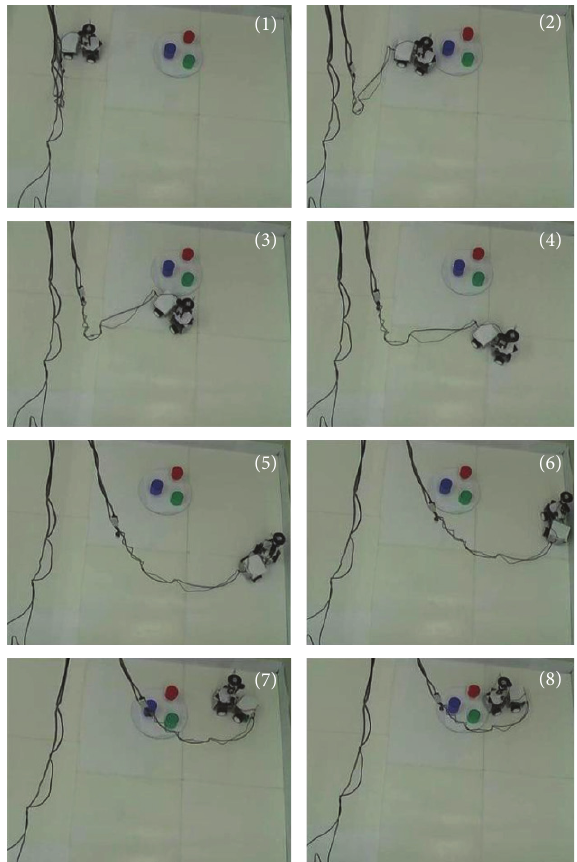
Figure 20: The snapshots of the second experiment where the initial position of the robot is not in the safe